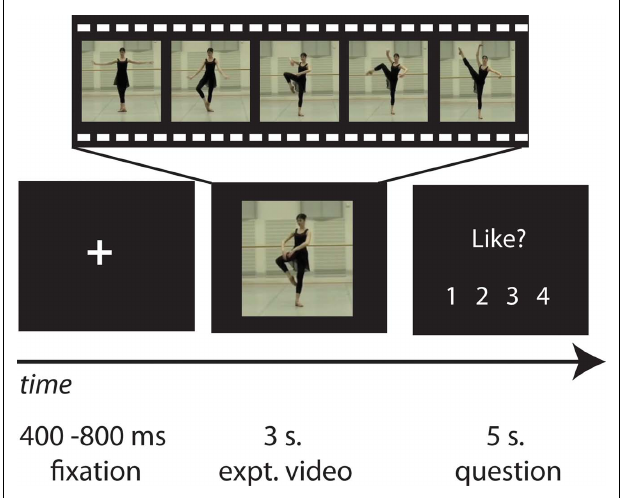
FIGURE 1 | Representative experimental stimuli and timecourse. The study began with a fixation cross, followed by a series of dance (or still body) videos, each of which was followed by a question referring to preceding video (how much participants liked the movement depicted, how well they think they could physically reproduce the movement, or some other question concerning the content of the video). Participants’ task was to watch each video closely and respond to the question as accurately as